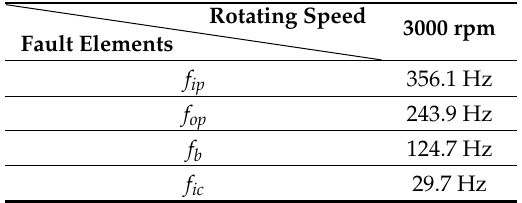
Table 1. Characteristic frequencies of the local damage of bearing elements at di ff erent